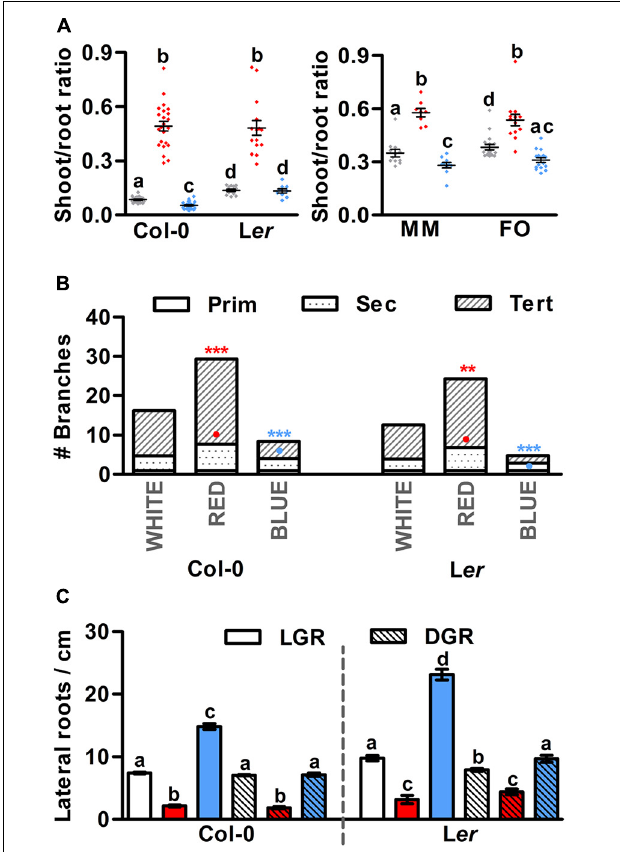
FIGURE 3 | Monochromatic red light promotes shoot growth and inhibits root branching in Arabidopsis. (A) Shoot-root ratio of 7 day old Arabidopsis seedlings (left) and 5 day old tomato seedlings (right), grown in white, red, or blue LED conditions. Arabidopsis ecotypes Columbia (Col-0) and Landsberg erecta (L er ), and tomato cultivars Moneymaker (MM) and Foundation (FO) were grown in dark-grown roots (DGR) LED conditions. (B) Number of primary (Prim), secondary (Sec) and tertiary (Tert) branches from the primary inflorescence of Arabidopsis Col-0 and L er plants grown in LED conditions until termination of the primary inflorescence. (C) Lateral root density of 14-day old Col-0 and L er seedlings grown in light-grown roots (LGR) and DGR LED conditions. Graph colors represent the LED conditions in (A,C) . LED conditions and ecotypes or cultivars were compared using a one-way ANOVA followed by a Tukey’s test (letters a–d indicate statistically significant differences, p < 0.05) in (A , C) . In (B) , monochromatic LED conditions (red or blue) were compared to white (control) using a two-sided Student’s t -test [bullets indicate significant differences in secondary branches ( p < 0.05), asterisks indicate significant differences in tertiary branches (*** p < 0.001, ** p < 0.01)]. Error bars represent standard error from mean in (A,C) ( n = 30), standard errors for (B) are listed in Supplementary Table S2 ( n = 20). Similar results were obtained in three (A,C) or two (B) independent experiments.